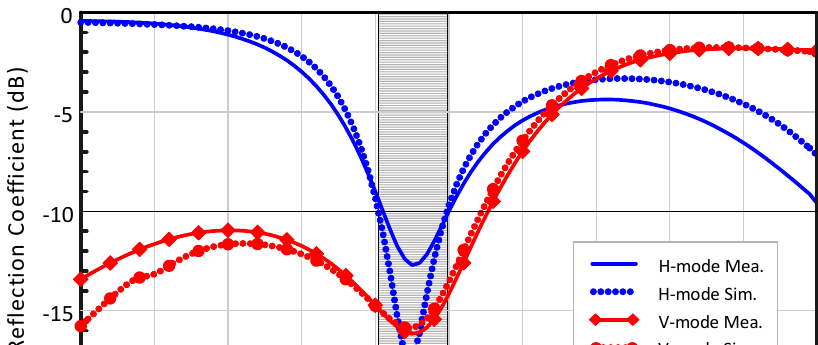
Figure 6. The fabricated prototype.